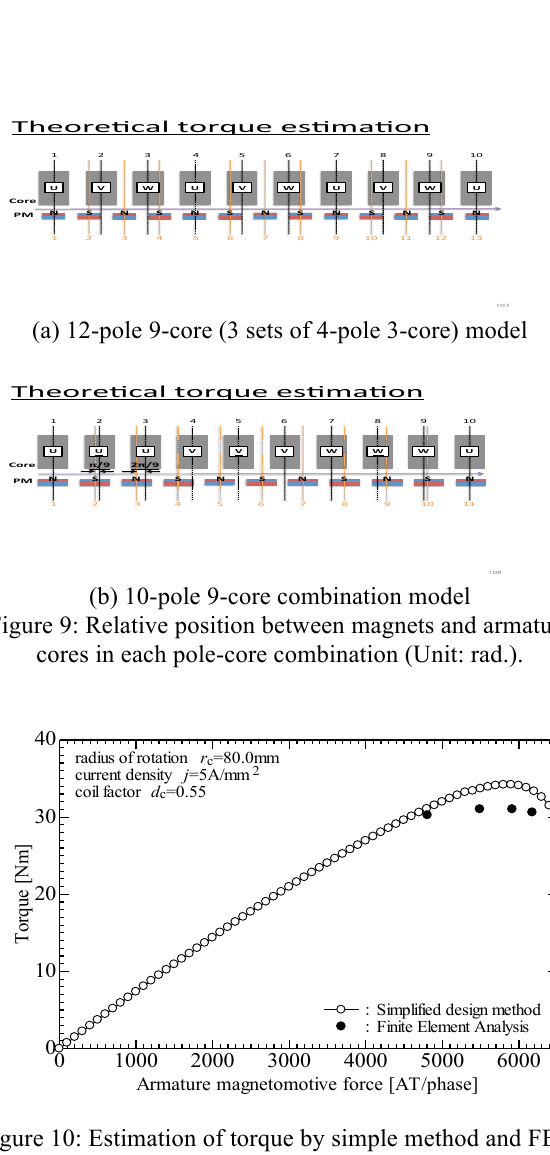
Figure 10: Estimation of torque by simple method and FEA.